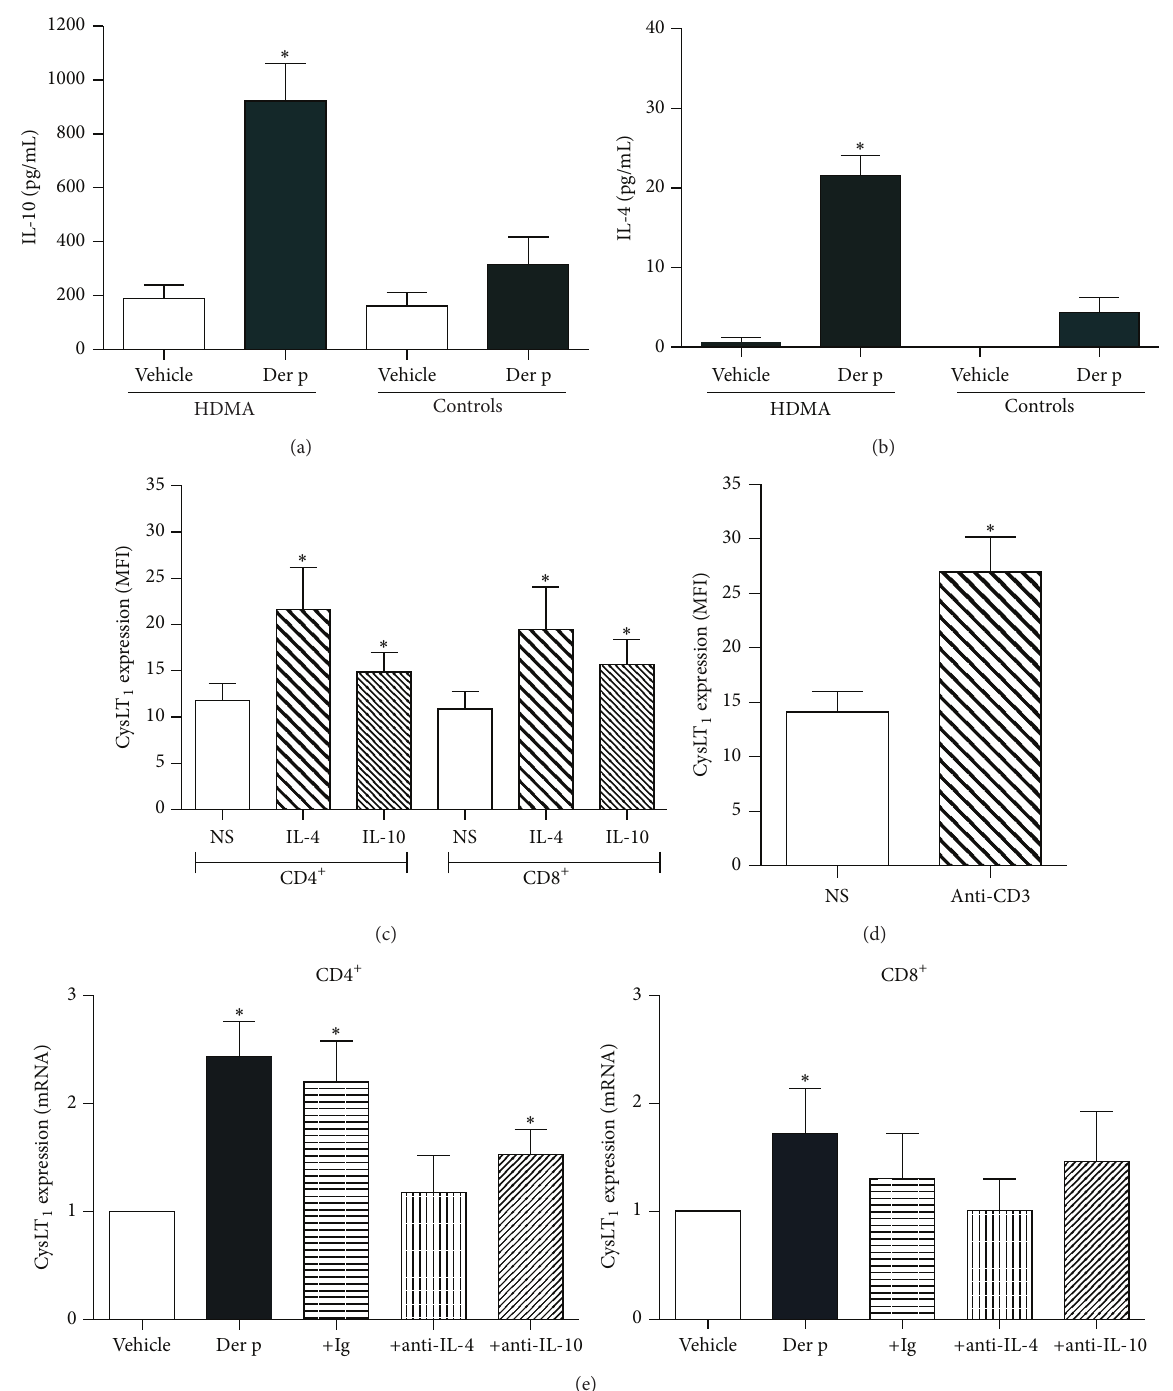
Figure 3: Cytokine production and effects in HDM-allergic and HDM-nonallergic individuals. PBMC from healthy controls and HDMA subjects were cultured for 72 h in the presence of glycerol vehicle or Der p before supernatants were collected for analysis. IL-4 (a) and IL-10 (b) production in cell-free culture supernatants were measured by ELISA. Results are expressed as means ± SEM. 𝑛 = 5 . CysLT 1 expression by T cells following stimulation with IL-4 (40 ng/mL) or IL-10 (20 ng/mL) (c) for 48 h or following TcR/CD3 stimulation (d) for 72 h was measured by flow cytometry. Data are expressed as geometric mean ( ± SEM) fluorescence intensity (MFI). (e) PBMC from HDM-allergic (HDMA) individuals were cultured for 48 h or 72 h with Der p in the presence of neutralizing anti-IL-4 or anti-IL-10 Abs or control IgG. CysLT 1 mRNA expression by CD4 + T cells and CD8 + T cells purified from PBMC at 48h after stimulation was measured by real-time quantitative PCR analysis. Data are presented as fold ( ΔΔ Ct) increases over GAPDH mRNA ± SEM for 𝑛 = 5 experiments; ∗ 𝑃 < 0.05 with respect to the